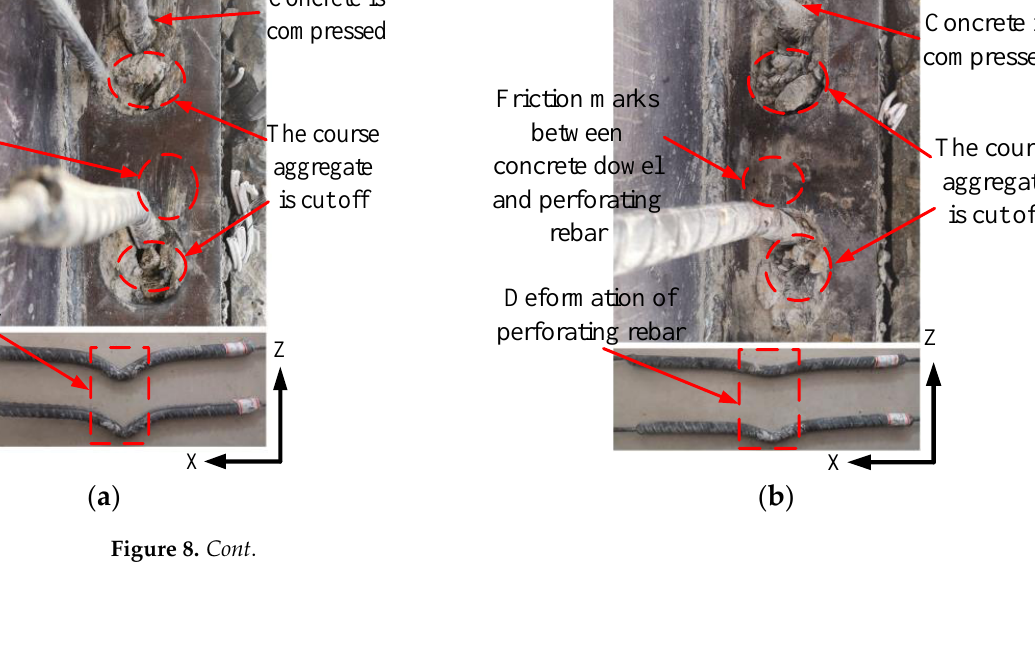
( f ) Figure 8. Inner failure modes of the perfobond connectors : ( a ) Inner failure mode of specimens with circular hole ; ( b ) Inner failure mode of specimens with long hole ; ( c ) Inner failure mode of specimens with high hole ; ( d ) Inner failure mode of specimens without stirrups; ( e ) Inner failure mode of specimens with single hole; ( f ) Inner failure mode of specimens without perforating rebar. 3.2. Strain Analysis of Perfobond Rib and Perforating Rebar To study the failure mechanisms of the connectors, the strains of the perfobond rib and perforating rebar were analyzed first. Specimens P-1 and P-4 were taken as representatives of double and single-hole connectors, respectively, and their load – strain curves (after removal of the damaged strain rosette) are shown in Figure 9. The strain